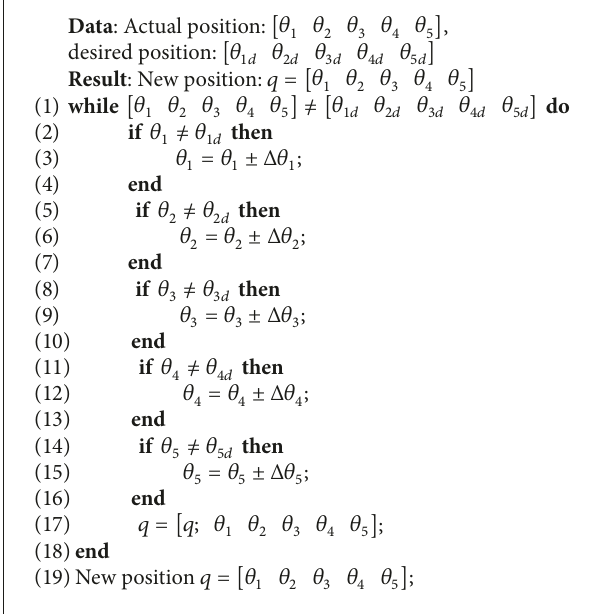
Algorithm 1: Algorithm for joint movement of MOVEJ.